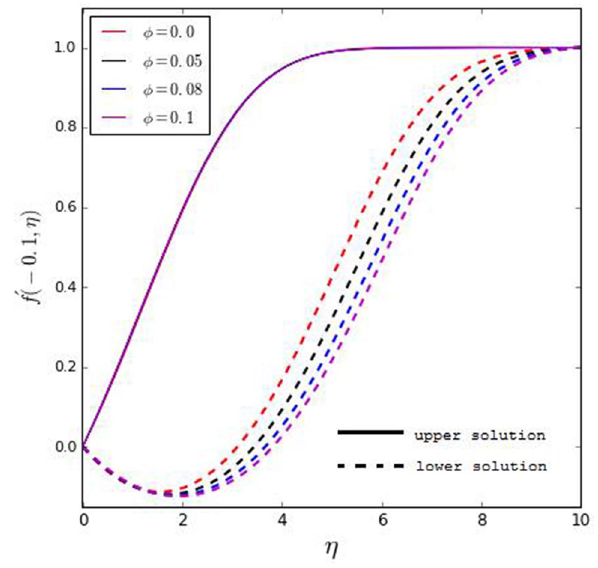
Fig. 10 Profiles for f � (− 0.15, 𝜂 ) for different 𝜙 = 0.05 for buoyancy opposing flow ( 𝜆 < 0 ) for fixed Pr = 6.7